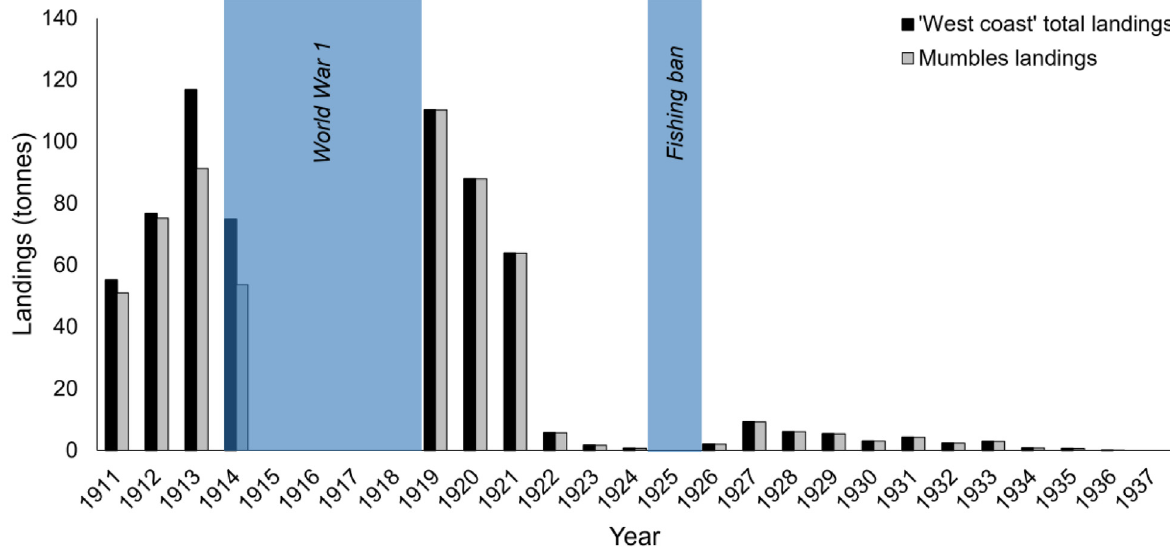
Fig. 3. Oyster landings for ‘ west coast ’ (including stations along the coast from Maryport, Cumbria to Sennen, Cornwall, and the Isle of Man) and for Mumbles from 1911 to 1937; black bar denotes total oyster landings recorded from ports on the ‘ west coast ’ , grey bar denotes oyster landings recorded at Mumbles, South Wales. Note, blue regions when landings were not recorded because of WWI (1914 – 1918) and a fi shing ban in Mumbles (1925). Landing information per station was not available prior to 1911 and Mumbles commercial oyster fi shery closed in